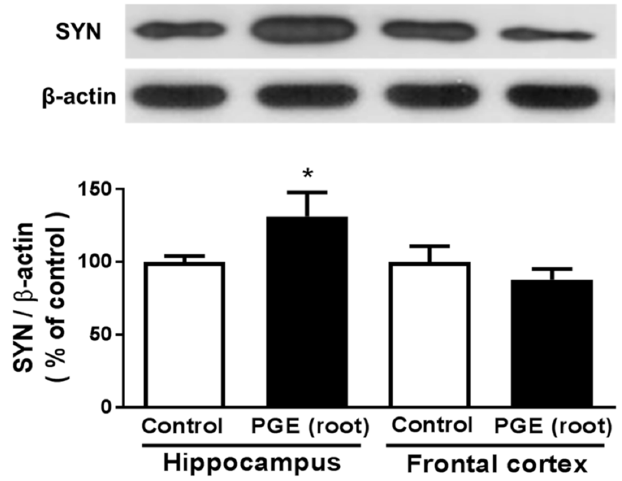
Figure 5. Immunoblotting analysis of synaptophysin expression in the hippocampus and frontal cortex after PGE (root)-administration. The PGE (root)-administered group shows a significantly higher expression of SYN in hippocampus than the controls. The PGE (root)-administered group shows no significant difference in the frontal cortex compared to the controls. Values are the mean + SEM. * p < 0.05 compared to the vehicle-treated control group. PGE, Platycodon grandiflorus extract. SYN, synaptophysin.